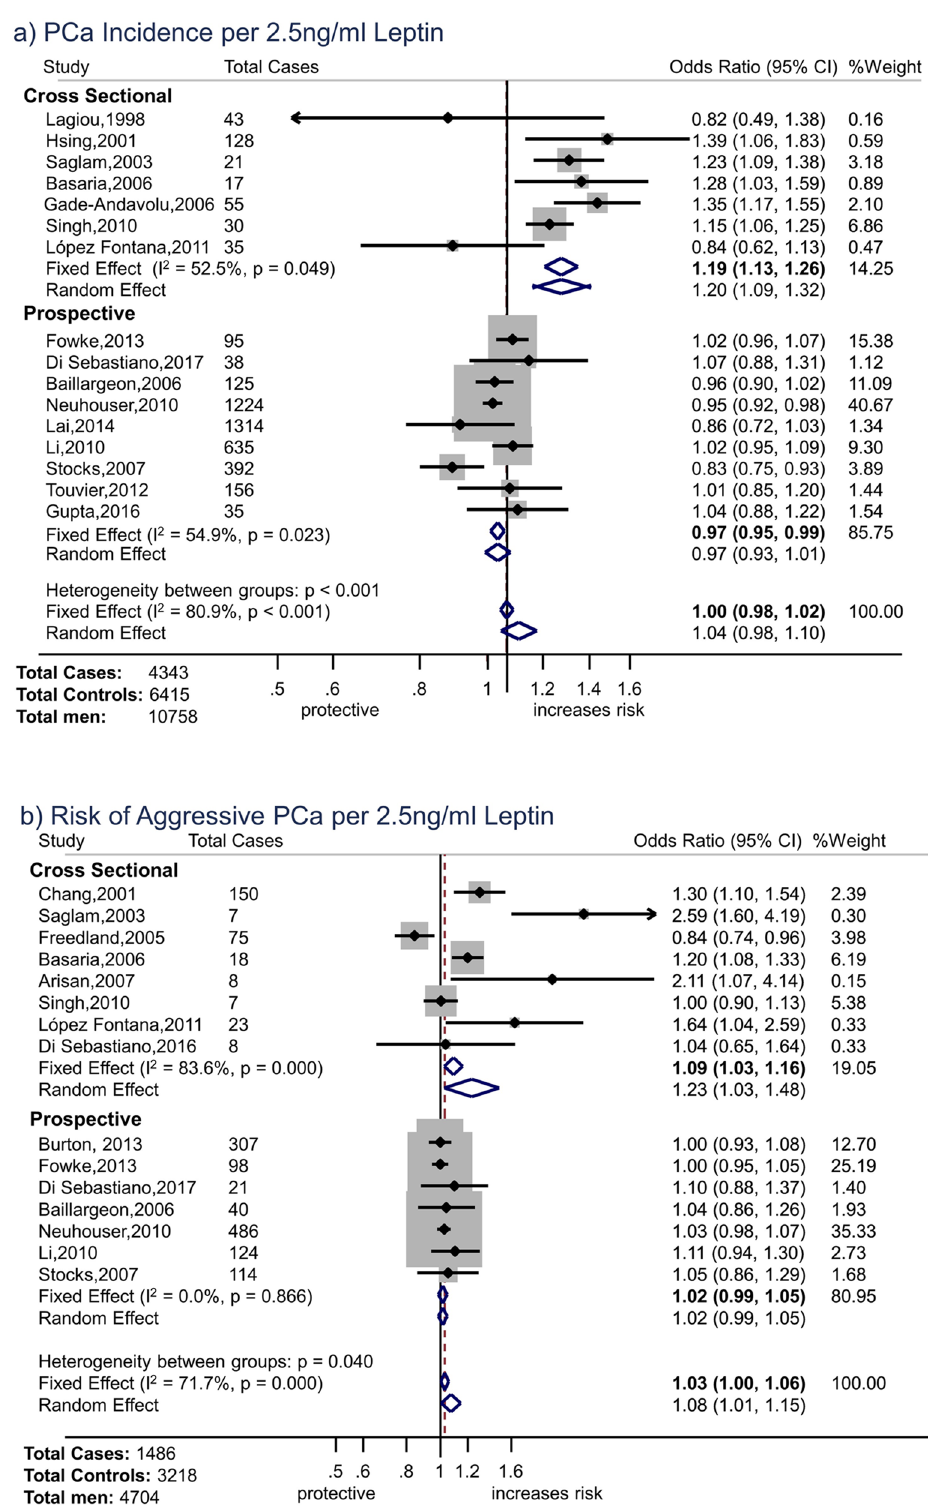
Figure 2. Forest Plots. ( a ) Forest plot of associations of leptin with total prostate cancer incidence (OR per 2.5 ng/ml increase in leptin) by study design. ( b ) Forest plot of associations of leptin with aggressive prostate cancer (OR per 2.5 ng/ml increase in leptin) by study design. ( c ) Forest plot of associations of adiponectin with total prostate cancer incidence (OR per 2.5 µg/ml increase in adiponectin) by study design. ( d ) Forest plot of associations of adiponectin with aggressive prostate cancer (OR per 2.5 µg/ml increase in adiponectin) by study design. Notes Ordered by date (cross-sectional studies) or mean time from blood draw to diagnosis (prospective studies). Weight for fixed-effects